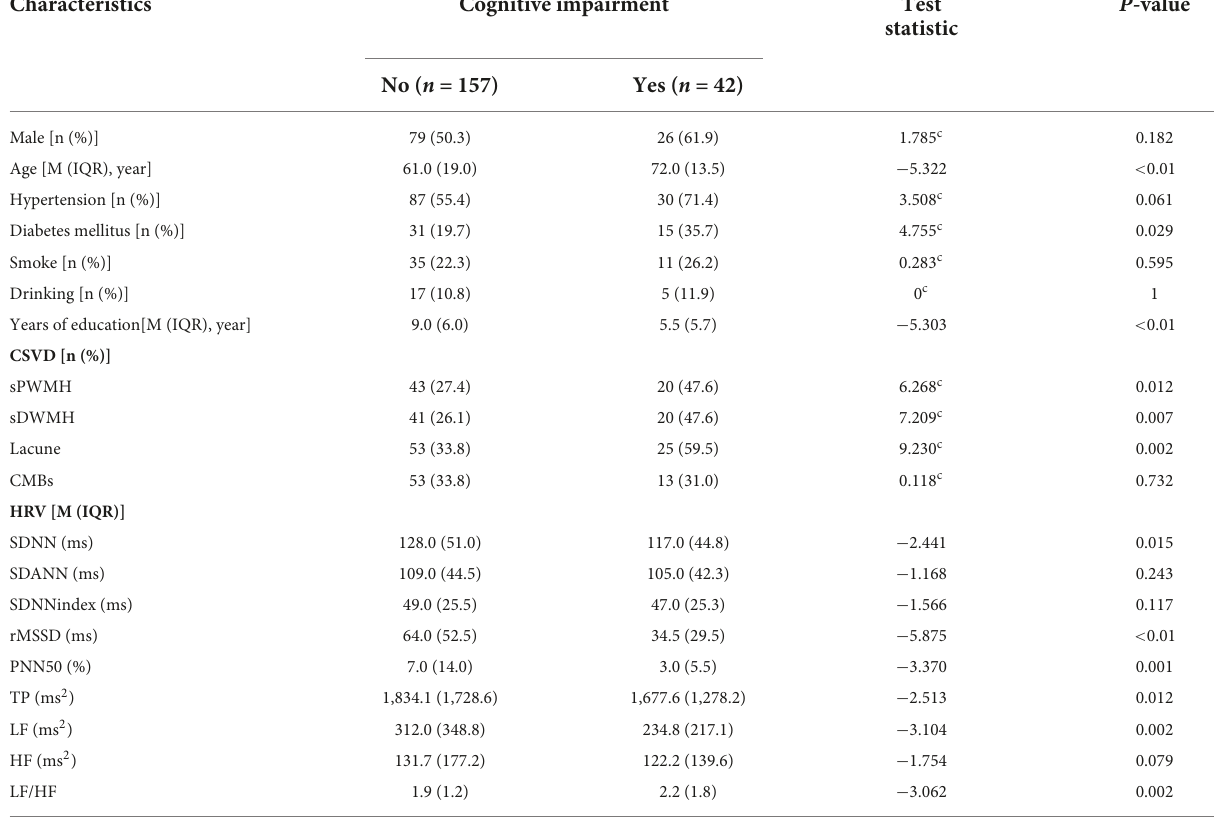
TABLE 3 Univariate analysis of factors related to cognitive impairment in enlarged perivascular space (EPVS) patients. Characteristics Cognitive impairment Test